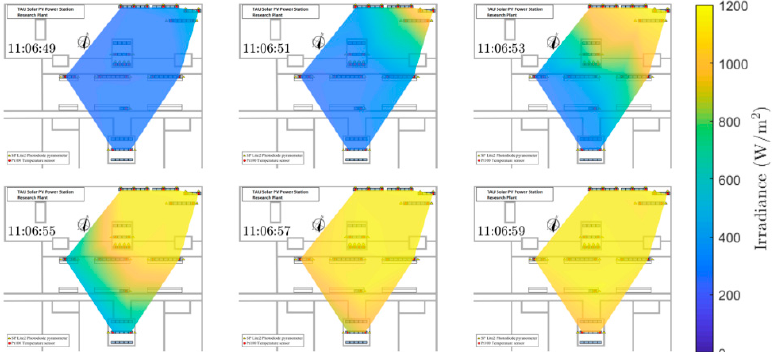
Figure 3. Irradiance profile of a leading edge of an overirradiance area moving approximately from north to south on the rooftop of Tampere University on 11 June 2016.